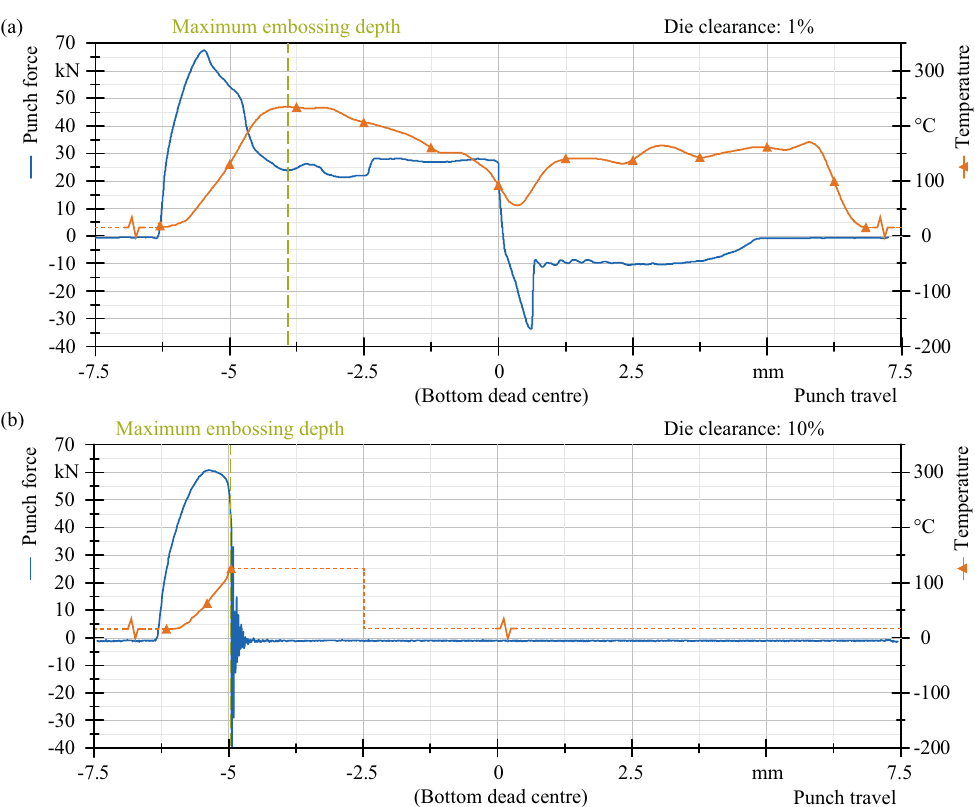
Fig. 3. One representative temperature pro fi le and punch force over the punch travel for a die clearance of (a) 1% and (b) 10% blanked with a punch stroke rate of 300 L/min. Table 2. Cutting surfaces and corresponding maximum embossing depth for 1%, 5%, and 10% die